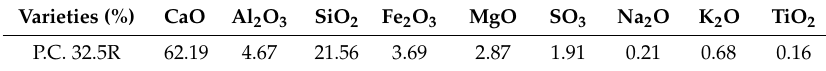
Table 2. The chemical components of composite Portland cement